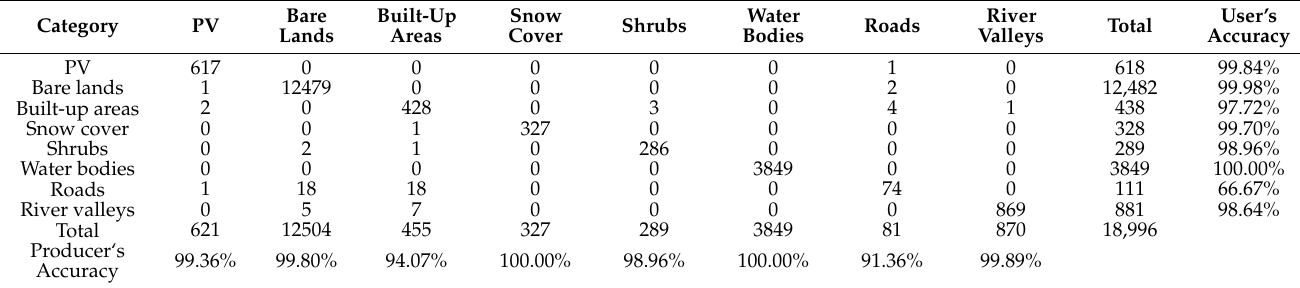
Table 7. Confusion matrix of the highest overall accuracy classifications.